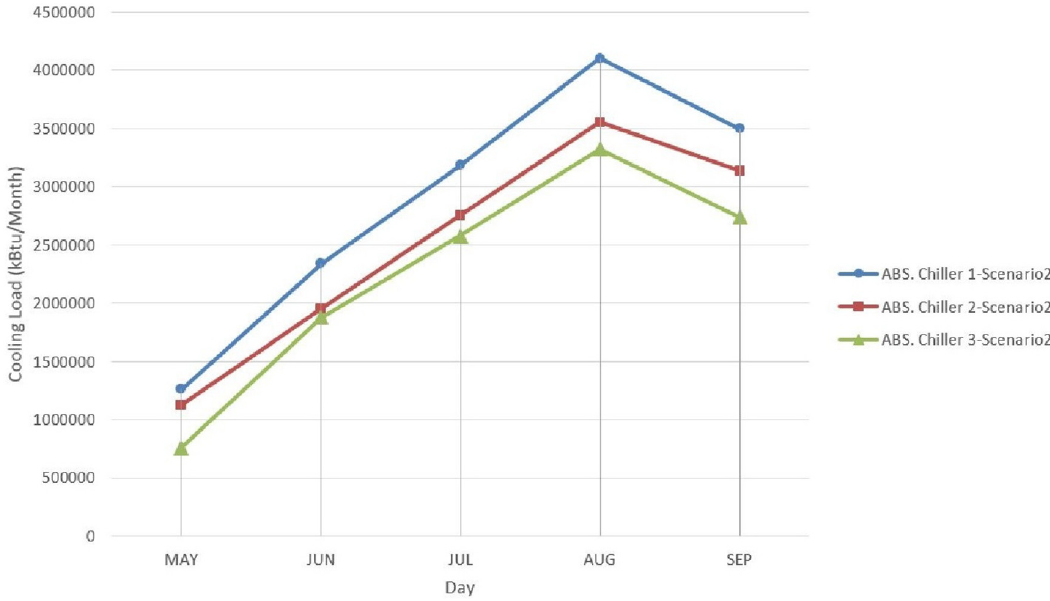
Fig. 9. Absorption chillers cooling load in scenario 2.